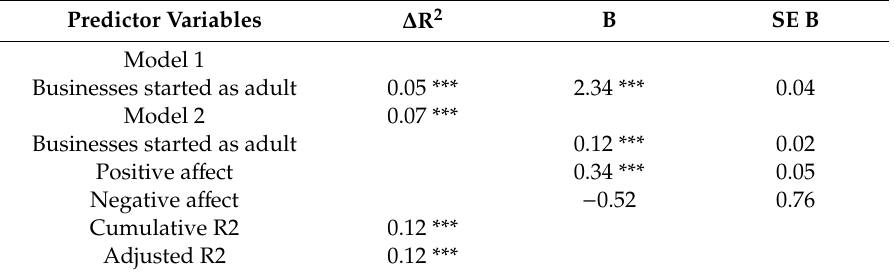
Table 2. Results of regression predicting entrepreneurial intention (EINT) based on positive and negative a ff ect.